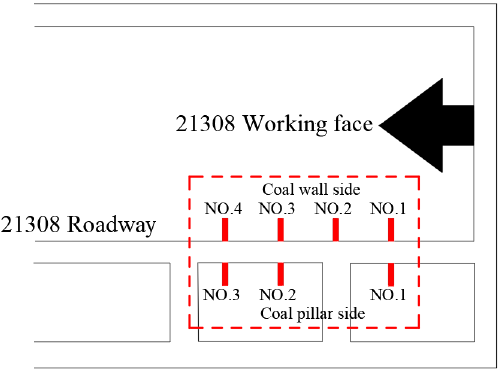
Figure 6. Arrangement of measuring stations for broken rock zone.